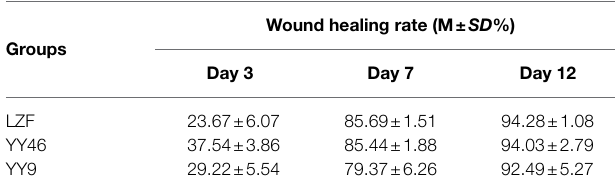
TABLE 2 | Effect of three kinds of LZF on the wound healing rate of rats ( n = 6, X ± s